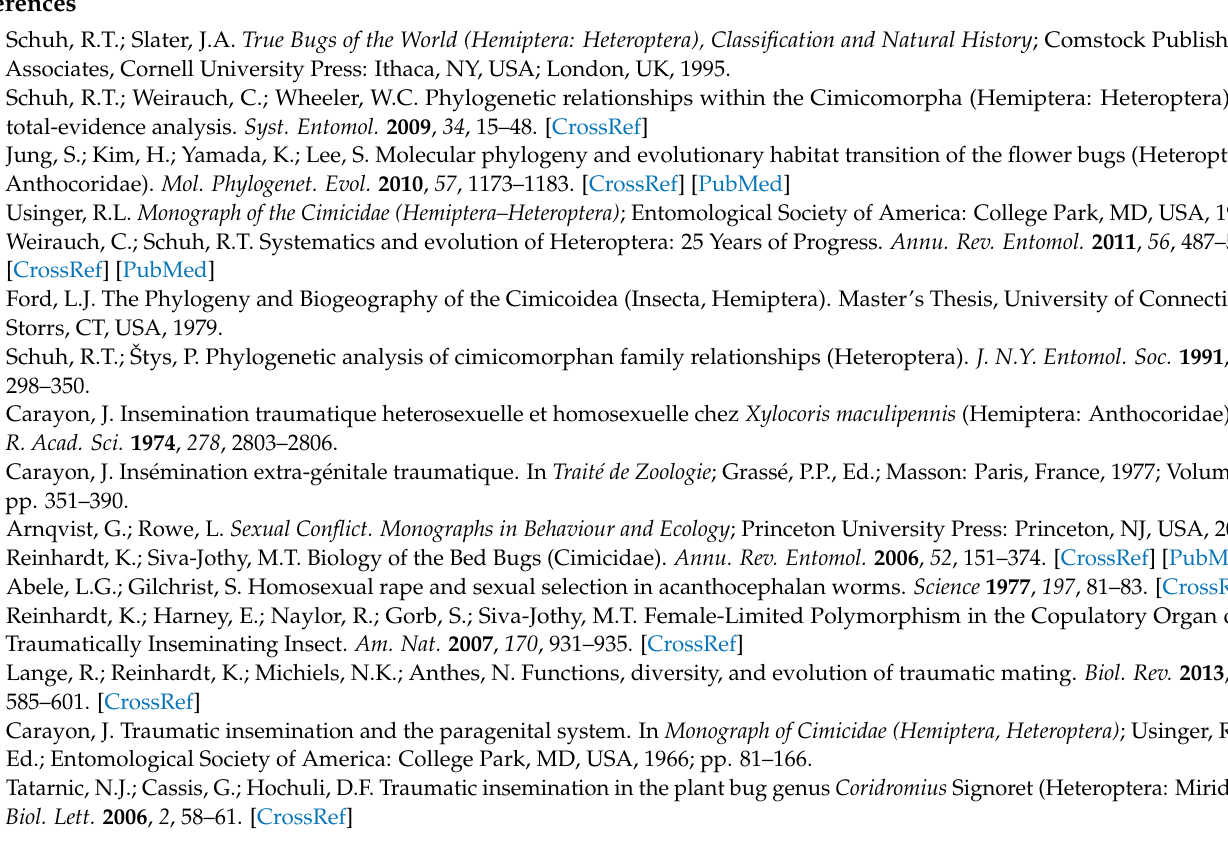
Figure S3: Reconstructions of parsimonious ancestral character states of traumatic insemination based on the parsimony tree (coded as Traumatic insemination—TI). Clades highlighted in red; standard insemination clade highlighted in green. Uncertain clades in terms of their copulating habits highlighted in light